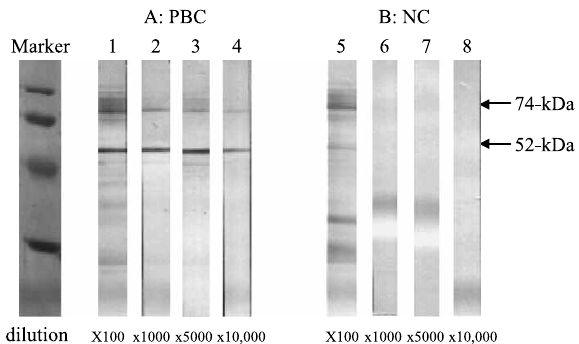
Figure 3. Dilution tests. Patterns observed with different serum dilutions of one PBC (panel A) and one NC serum (panel B) are shown. We note that the PBC serum reacts with the 74 and 52kDa proteins at 1:10,000 dilution while reactivities were lost at 1:1000 for NC.